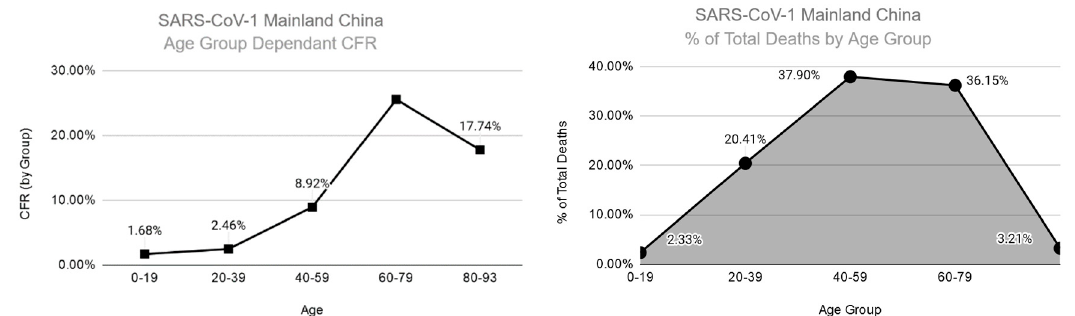
Figure 1. Age group dependent CFR (left column) as compared to % of total deaths for various age groups (right column) mortality (left column) for SARS-CoV-1 in Mainland China. Showing how CFR is much higher for advanced age while the majority of deaths occurred in younger populations exposed to the virus in both the community and hospitals [24].